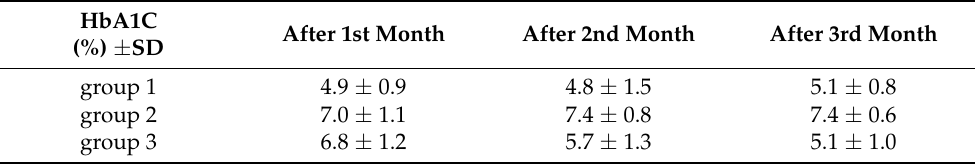
Table 2. Mean HbA1c for every measurement point in the three groups of rats (group 1, n = 12; group 2, n = 10; group 3, n =